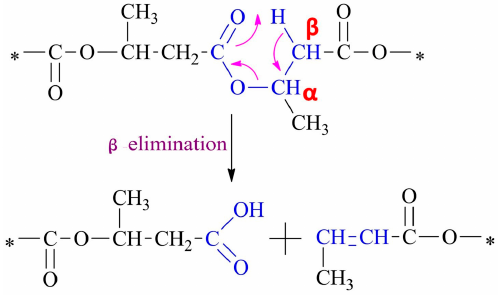
Figure 4. Schematic of the thermal degradation of P3HB by random chain scission reaction. Reprinted with permission from [31]. Copyright © 2008 Elsevier Ltd.